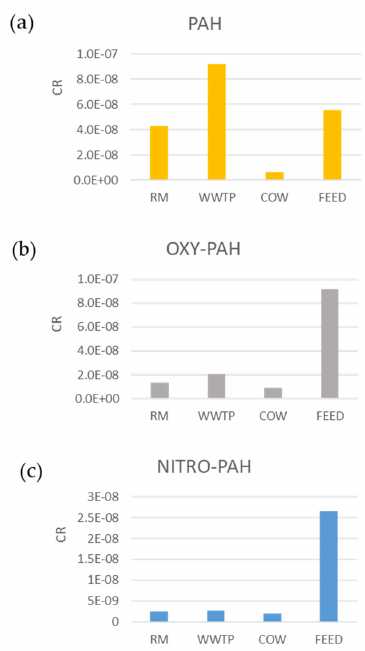
Figure 8. Carcinogenic risk from PAHs ( a ), OXY- ( b ) and NITRO-PAHs ( c ) in PM10 in the four sampling sites. CR ranges from 6 × 10 − 9 to 9 × 10 − 8 for PAHs, from 9 × 10 − 9 to 9 × 10 − 8 for Oxy-PAHs and from 3 × 10 − 9 to 2.7 × 10 − 8 for Nitro-PAHs and all values are below the risk acceptable level (1 × 10 − 6 ). Nevertheless, significant differences can be observed among the sites. CR from PAHs is higher in WWTP, while Oxy- and Nitro-PAHs contribute to greater health risk in the FEED site. The COW site shows the lowest CR values for all classes of compounds. As demonstrated by PCA, in WWTP the highest CR values associated with PAHs may be due to the predominance of pyrolytic sources in agreement with site location. WWTP can be considered a suburban area characterized by both vehicular traffic and agricultural activities that require the use of industrial vehicles such as tractors, threshers, etc. In addition, some activities such as open burning of brushwood, straw and stubble are widely spread in the spring. CR in the FEED site is mainly affected by PAH derivatives from emissions of diesel and gasoline engines in accordance with work activities carried out in the area: seed grinding with motor mill and feed transport with industrial motor vehicles. Therefore, the higher values obtained may be due to emissions of diesel and gasoline engines of vehicles used to mill and move feed. Figure 9 shows percentage distribution of CR from PAHs and derivatives associated with ultrafine, fine and coarse fractions of PM. In RM and WWTP sites, despite the greater abundance of organic compounds in the ultrafine fraction (Section 3.2—Figure 4), the higher CR percentage was obtained in the fine fraction. This is probably due to the compound distribution in the three PM fractions, since CR estimation depends on a single